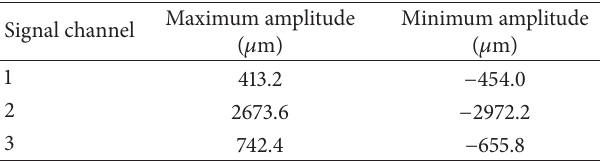
Table 3: Vibration amplitude of each channel under the triangle wave motion curve.